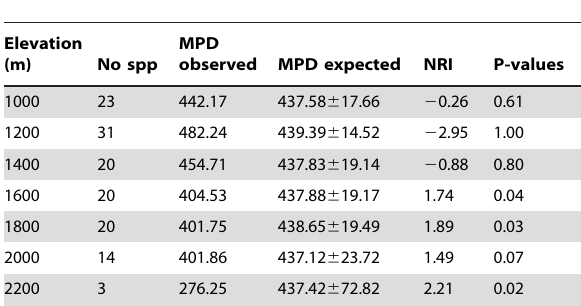
Table 3. Phylogenetic community structure among vegetation plots along an elevational gradient on Mount Rinjani,